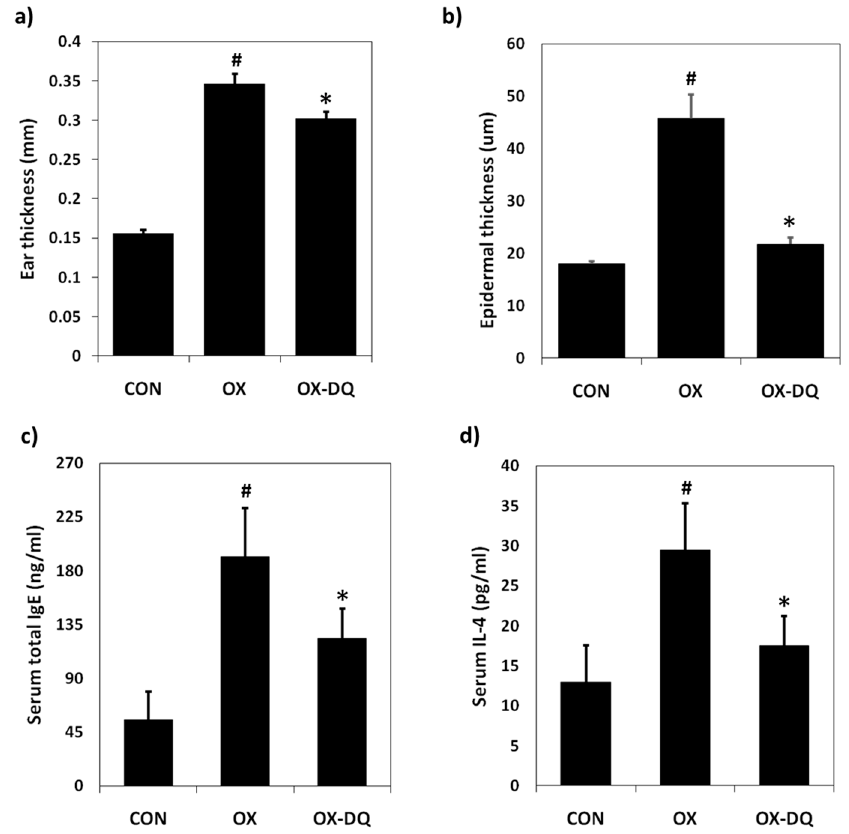
Figure 2. Effects of DQ on the ear thickness and serum IgE and IL-4 levels in oxazolone-induced symptoms in BALB/c mouse ears. CON: control group, DNCB: DNCB-treated group, AD-like symptoms in BALB/c mouse ears. CON: control group, DNCB: DNCB-treated group, DNCB-DQ: oxazolone and 1% D. quinqueloba EtOH extract-treated group. ( a ) Ear thickness; ( b )